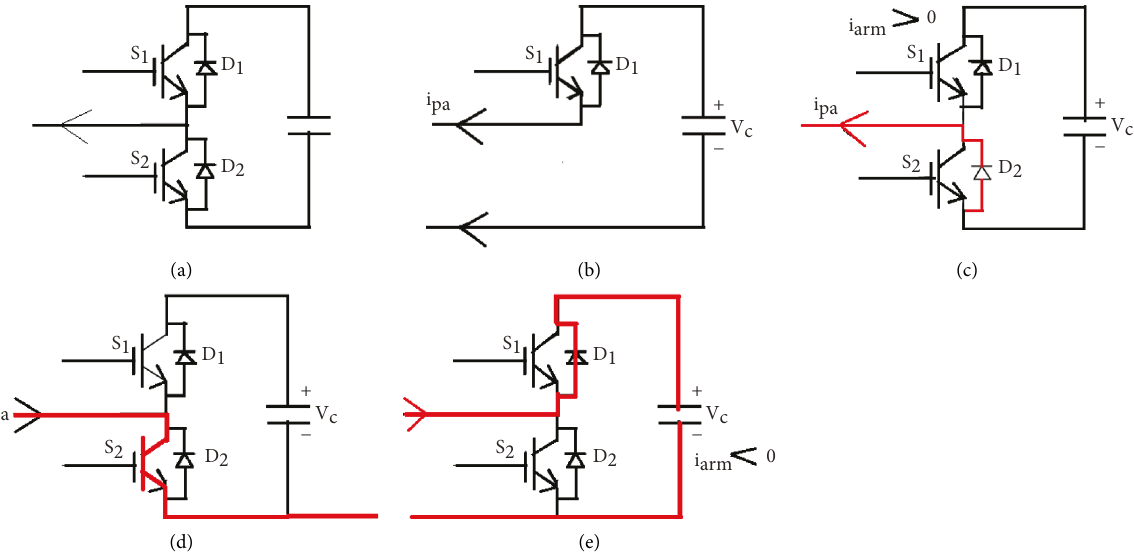
Figure 2: Different modes of operation of the MMC. (a)MMC submodule operations. (b)Capacitor in the discharge mode, (c)submodule by the passed mode, (d)submodule by the passed mode, and (e)submodule-inserted capacitor in the charge mode.